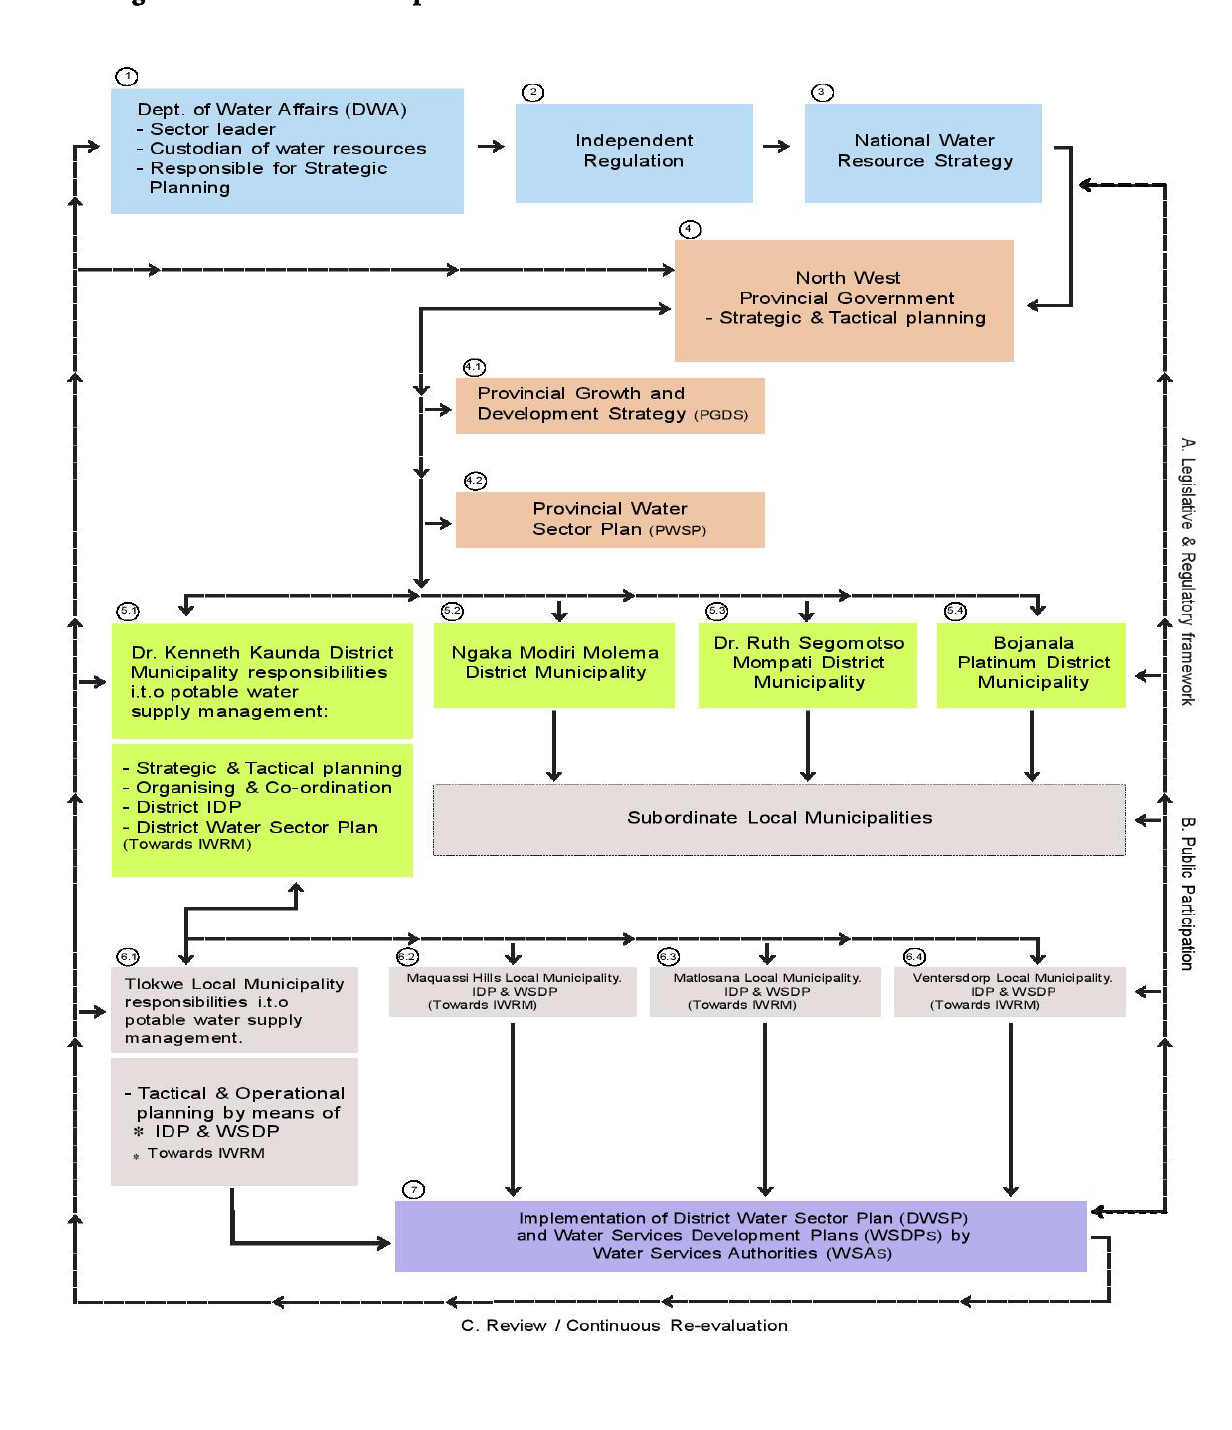
Figure 2: Water sector plan/functional flow chart for the Dr